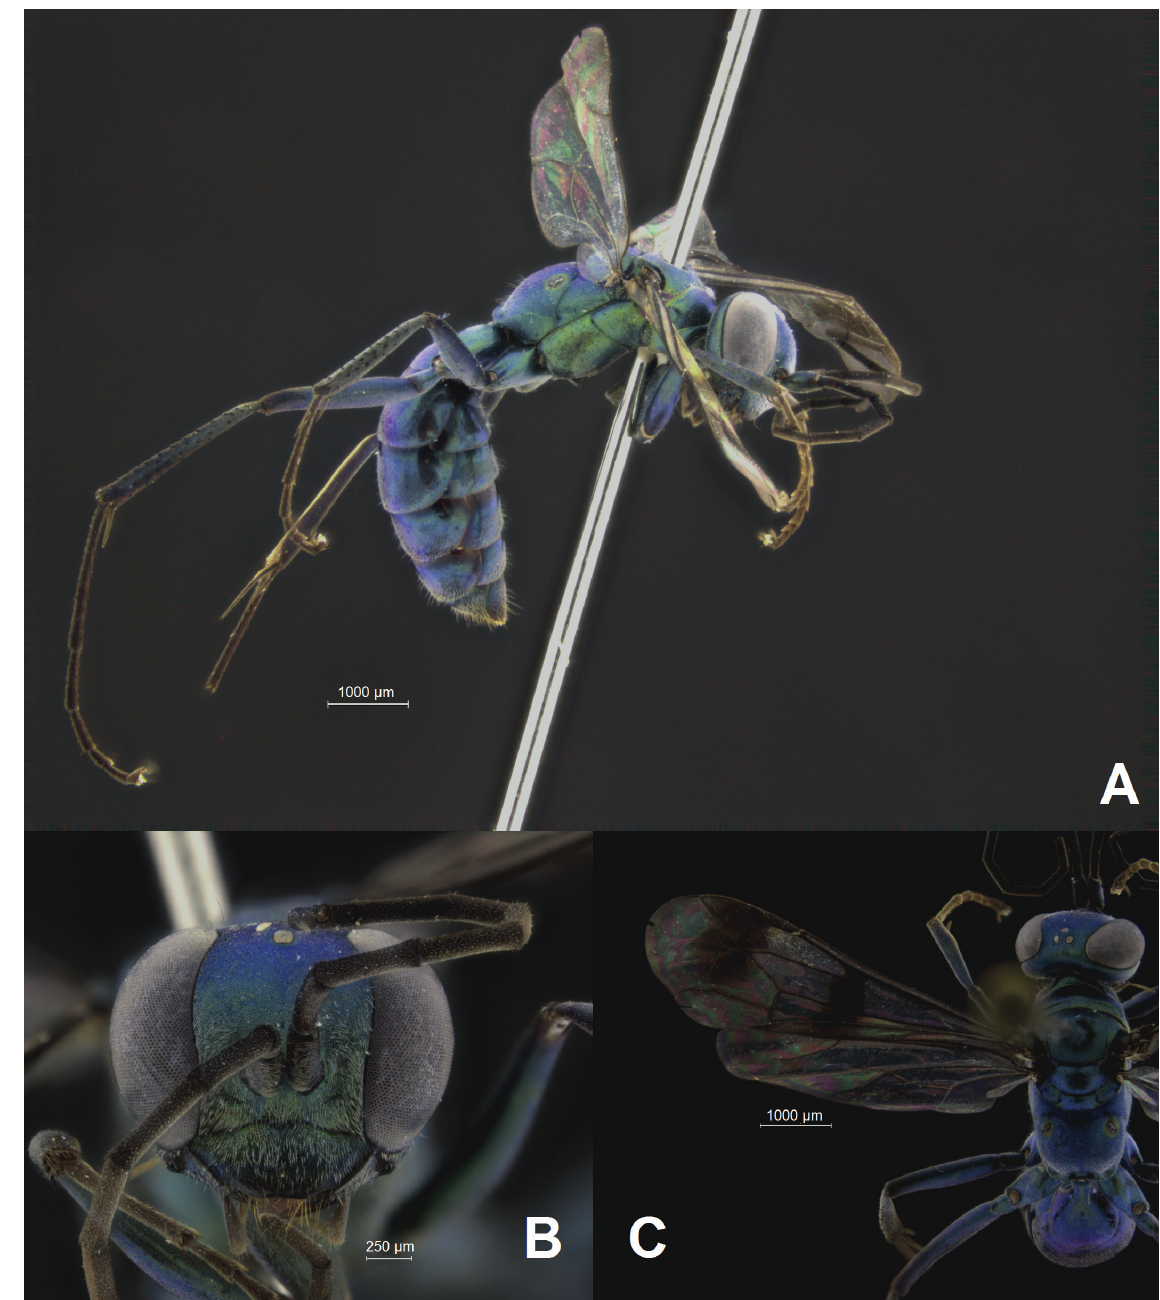
Fig. 1. Ageniella caerulea sp. nov., ♀, holotype (INPA). A . Profile. B . Head, frontal view. C . Fore wing and dorsal